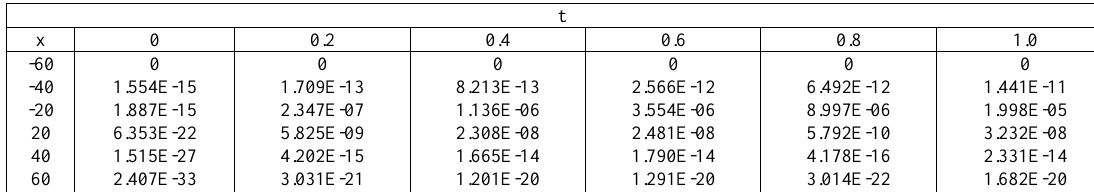
Table 2. Absolute errors for u(x, t) obtained by the sixteen-terms approximate solution of the HAM